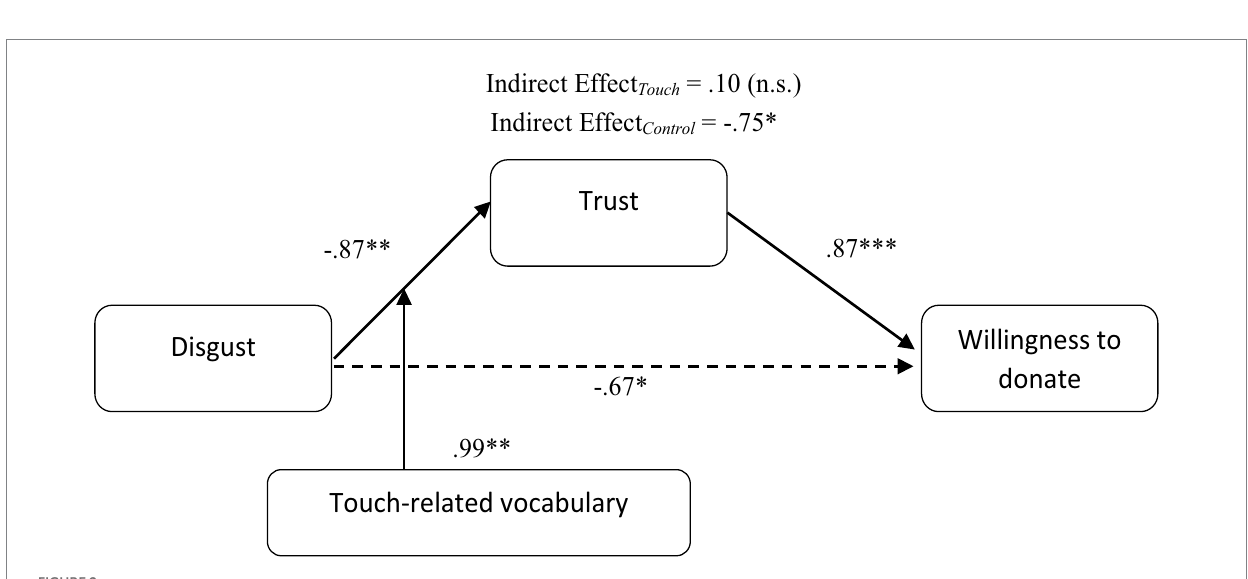
FIGURE 2 Study 2: The mediating role of trust in the interacting effect of disgust and touch-related vocabulary on